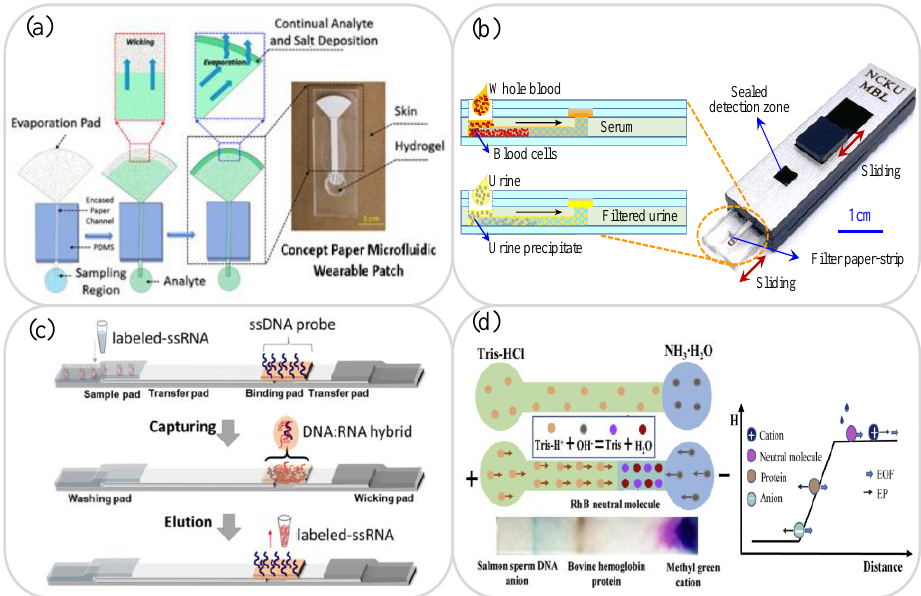
Figure 1. ( a ) Showing working principle of sweat collection in paper-osmotic microfluidic device. Reprinted with permission from ref. [49]. Copyright 2020 AIP Publishing.